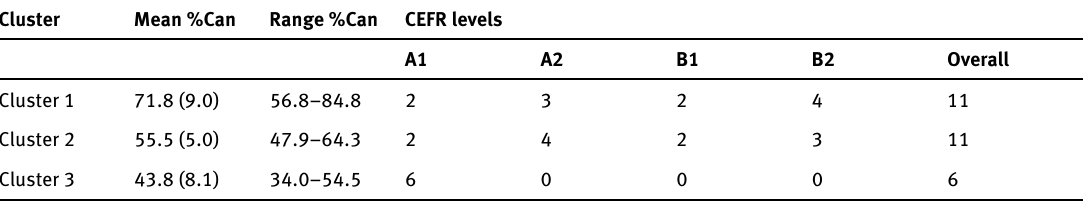
Table 13. Means and standard deviations (SD) for the percentages of canonical transcriptions per cluster for the listener data, including number of Spanish learners per CEFR language proficiency level; %Can = percentages of canonical